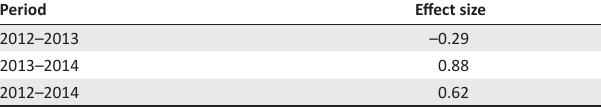
TABLE 5: The effect sizes for different periods.